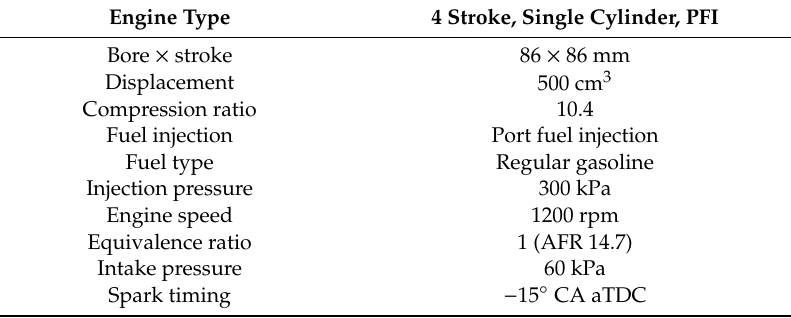
Table 1. Engine specifications and test conditions. PFI: port fuel injection; CA aTDC: Crank-Angle after Top Dead